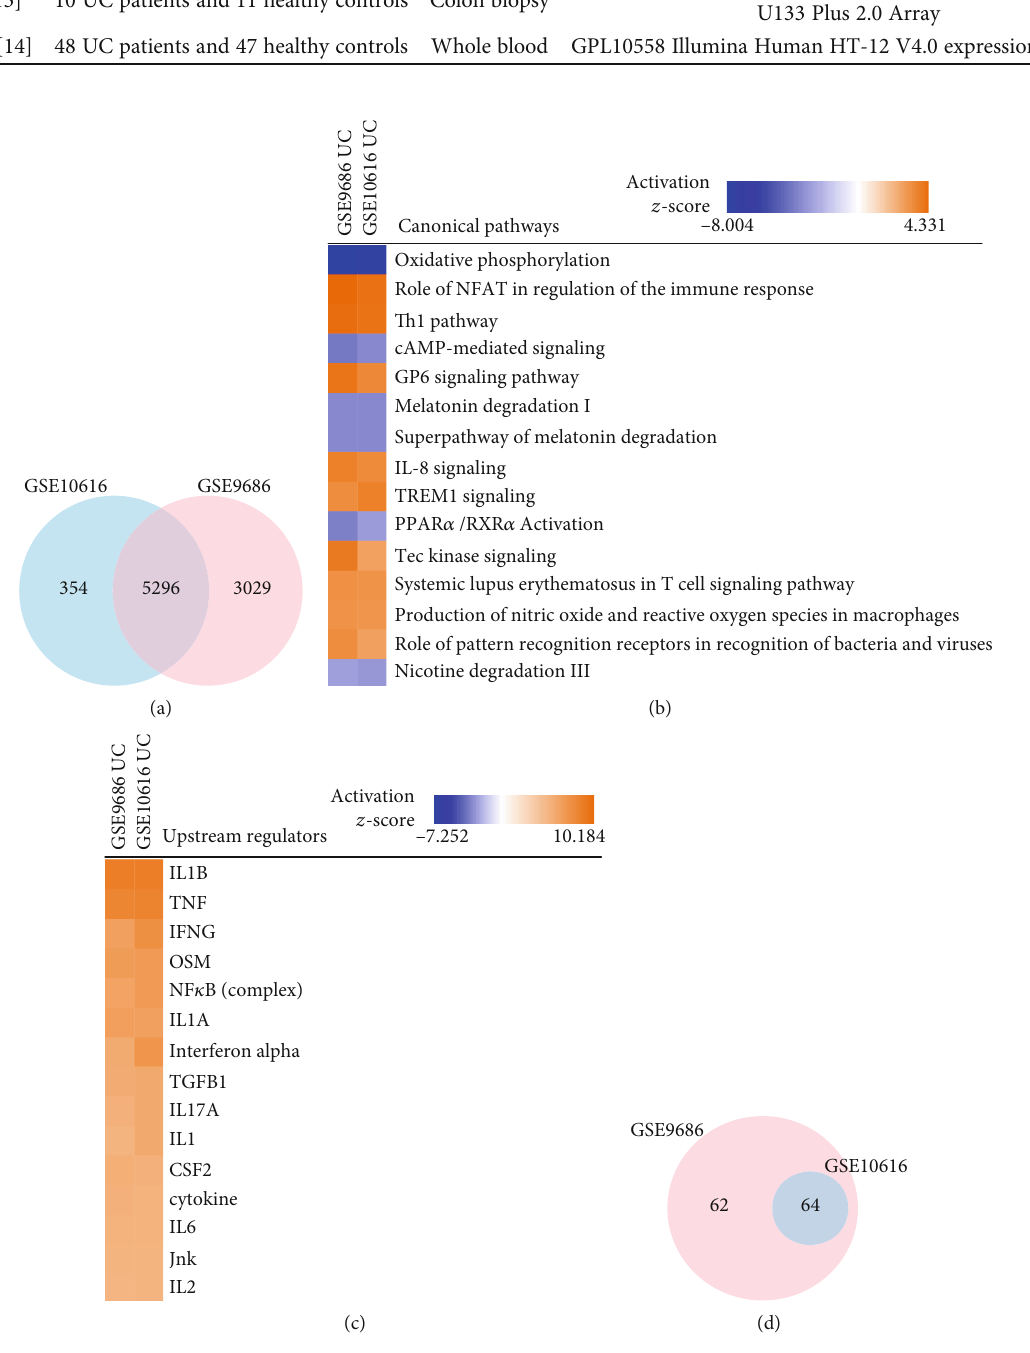
Figure 1: Analysis of shared pathways and upstream regulators in two expression pro fi ling datasets of colonic biopsies from patients with ulcerative colitis. (a) Venn diagram of di ff erentially expressed genes from the two datasets. (b) Canonical pathway comparisons between the two datasets. Orange indicates upregulated, and blue indicates downregulated pathways. Color intensity corresponds to signi fi cance, as indicated by the activation z -score bars below the pathways and upstream regulators. (c) Predicted upstream regulators of the mapped di ff erentially expressed genes. (d) Venn diagram of predicted overlapping biomarkers from the two datasets. Dots mean nonsigni fi cant values.